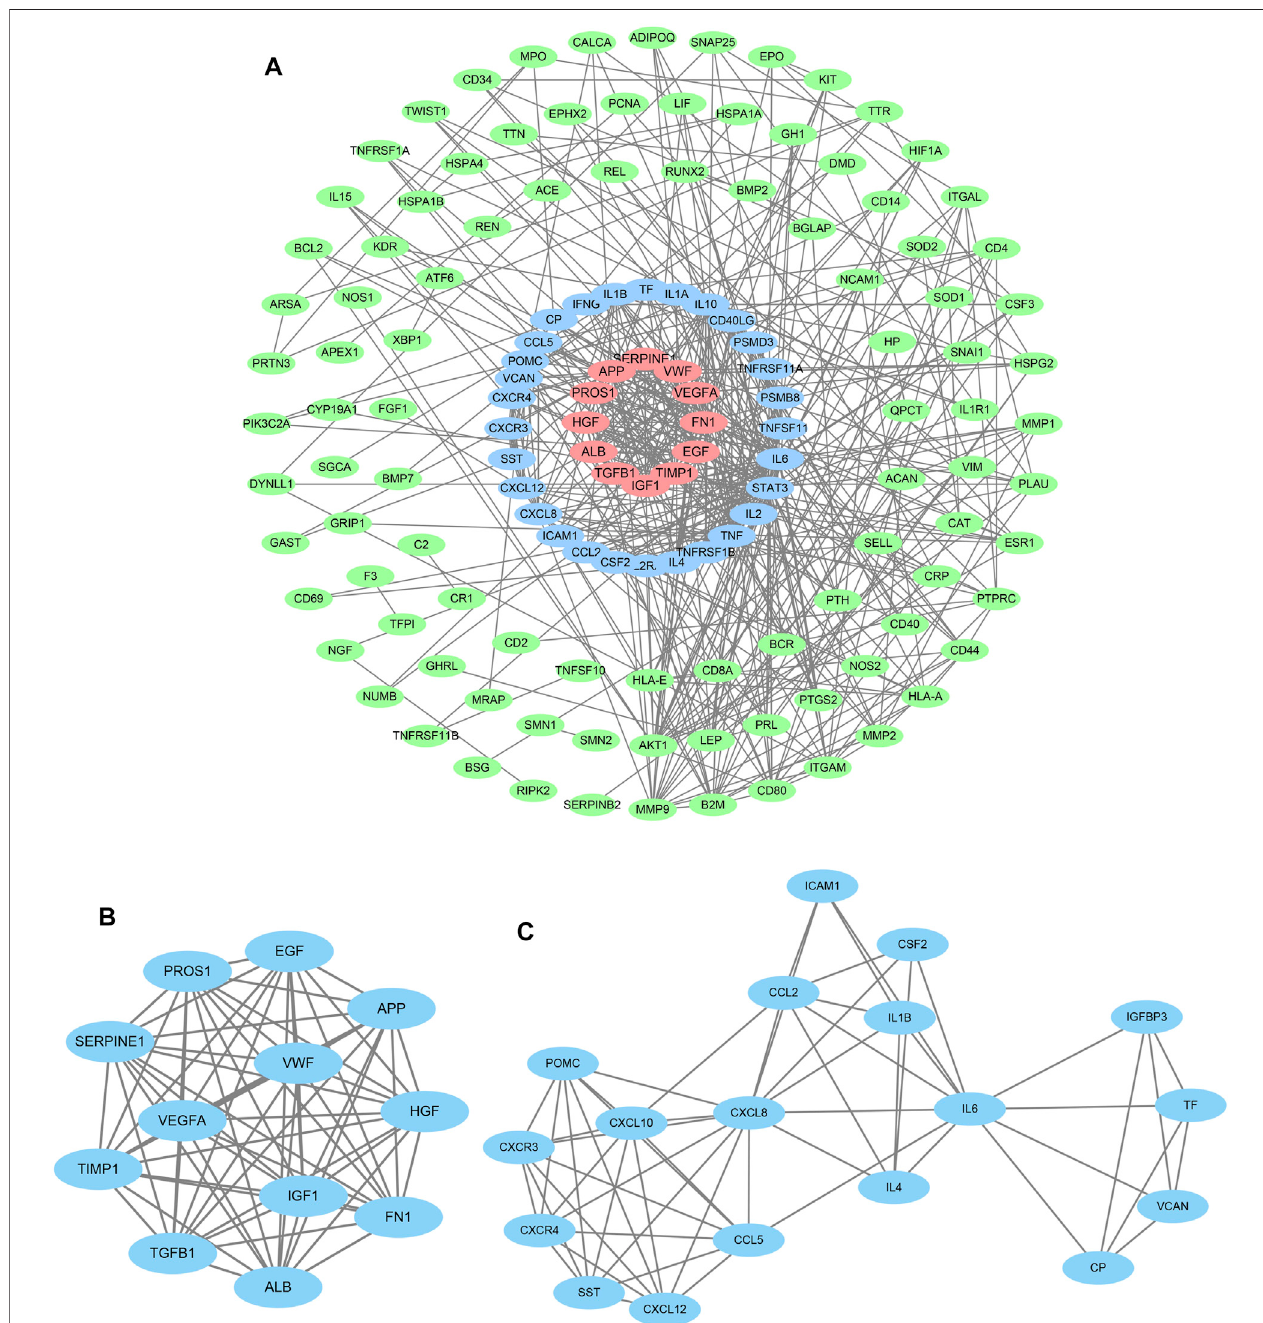
FIGURE 3 | Protein – protein interaction analysis and gene module analysis. (A) Based on the STRING online database, 142 genes and 507 edges formed the networkwhichwasunderthemaximuminteractionscore > 0.9(highcon fi dence). (B) Cluster1:the fi rstsigni fi cantmodulefromthePPInetwork,containing12nodesand 86 edges. (C) Cluster 2: the second signi fi cant module from the PPI network, containing 18 nodes and 54 edges.